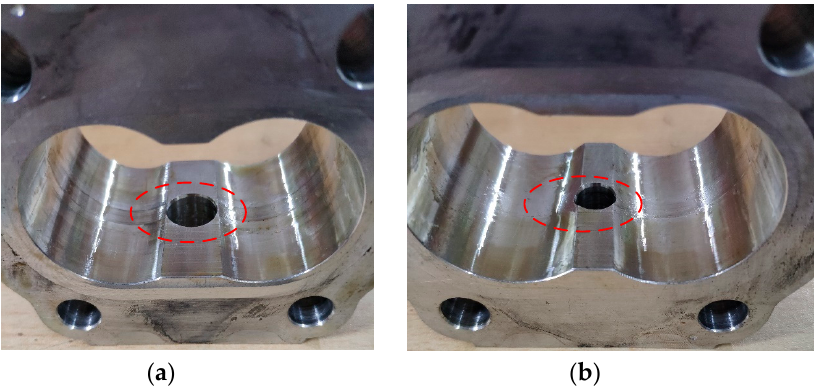
Figure 20. Gear pump radial wear: ( a ) suction port; ( b ) pressure port.